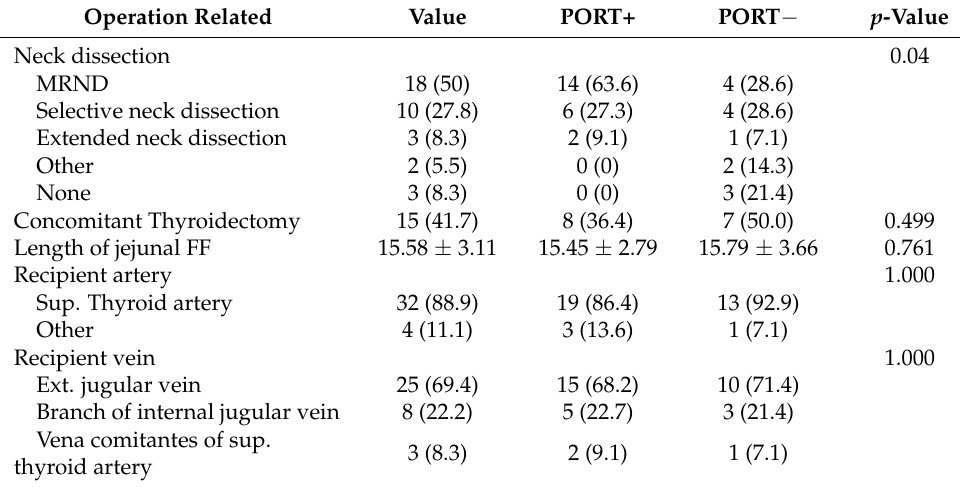
Table 3. Baseline characteristics of the study population.